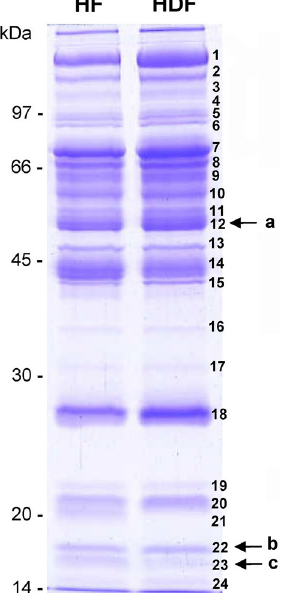
Figure 2. SDS-PAGE of plasma samples from HF and HDF patients for protein detection and MS identification. Gel stained with Coomassie blue shows the stained proteins in albumin/IgG-depleted plasma pools from HF and HDF samples. Detected proteins are indicated with numbers (bands 1–24) and were processed for identification by MALDI-TOF MS. Letters indicate the proteins differentially detected and shown in Fig. 1. The numbers on the left indicate the apparent molecular mass in kDa. The figure shows representative HF and HDF samples ran in the same stained